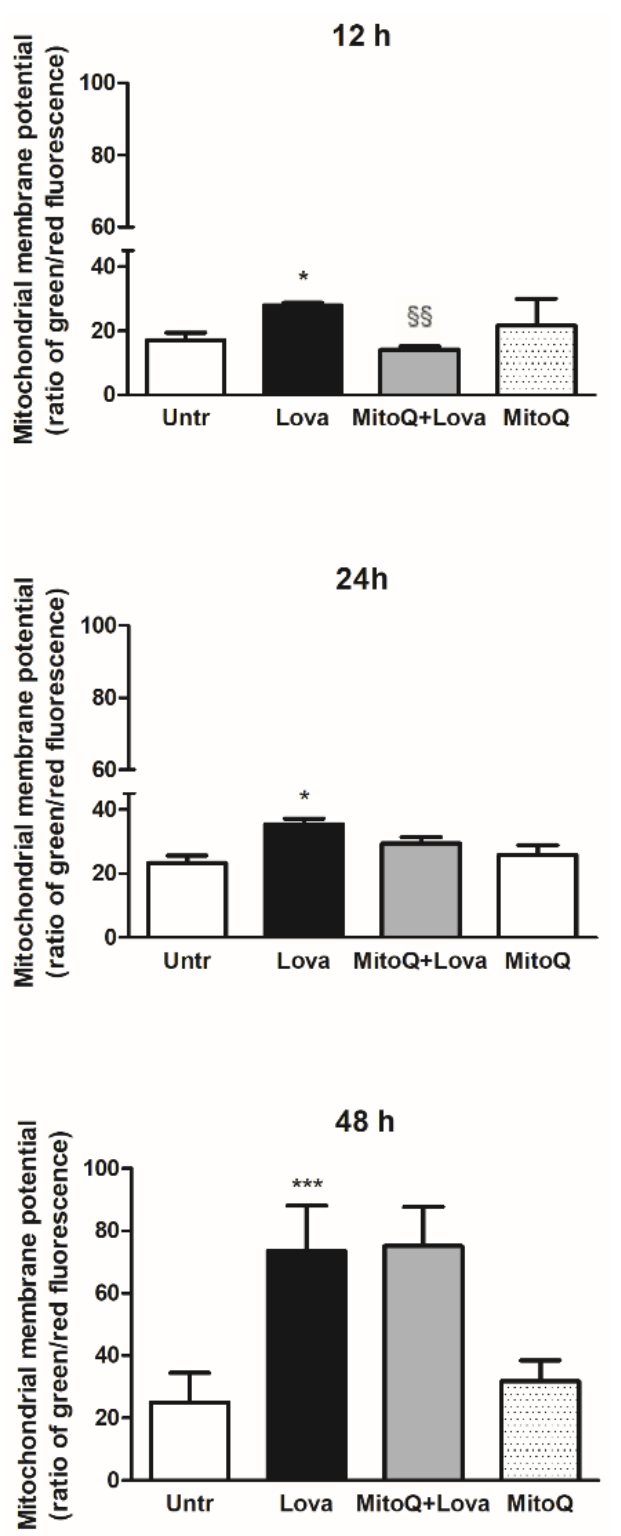
Figure 2. JC-1, a lipophilic cation dye, staining to evidence the mitochondrial membrane potential ( N = 4 independent experiments). Data are shown as means ± SD (Lova vs. Untreated: * p < 0.05; *** p < 0.001; MitoQ + Lova vs. Lova: §§ p < 0.01 based on one-way ANOVA, post-test Bonferroni). Abbreviations: Untr, untreated; Lova, lovastatin.